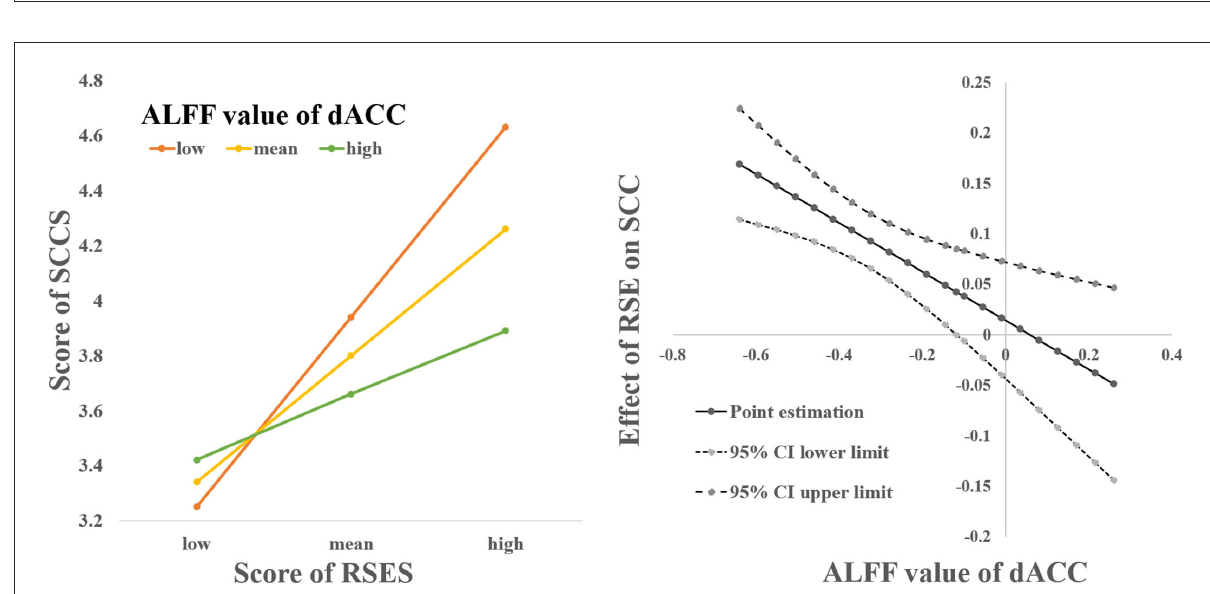
FIGURE2 The relationship between SCCS and SES was modulated by spontaneous activation of the right dACC.